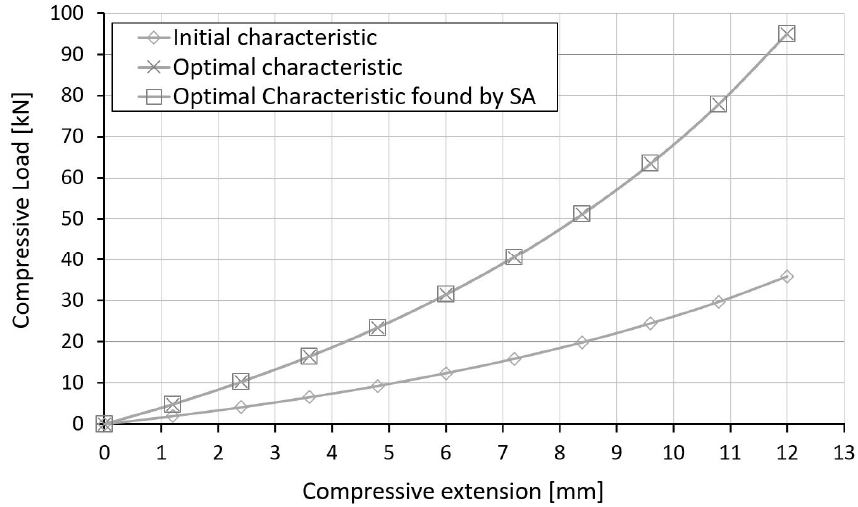
Table 10. The optimal design variables found by the simulated annealing algorithm.